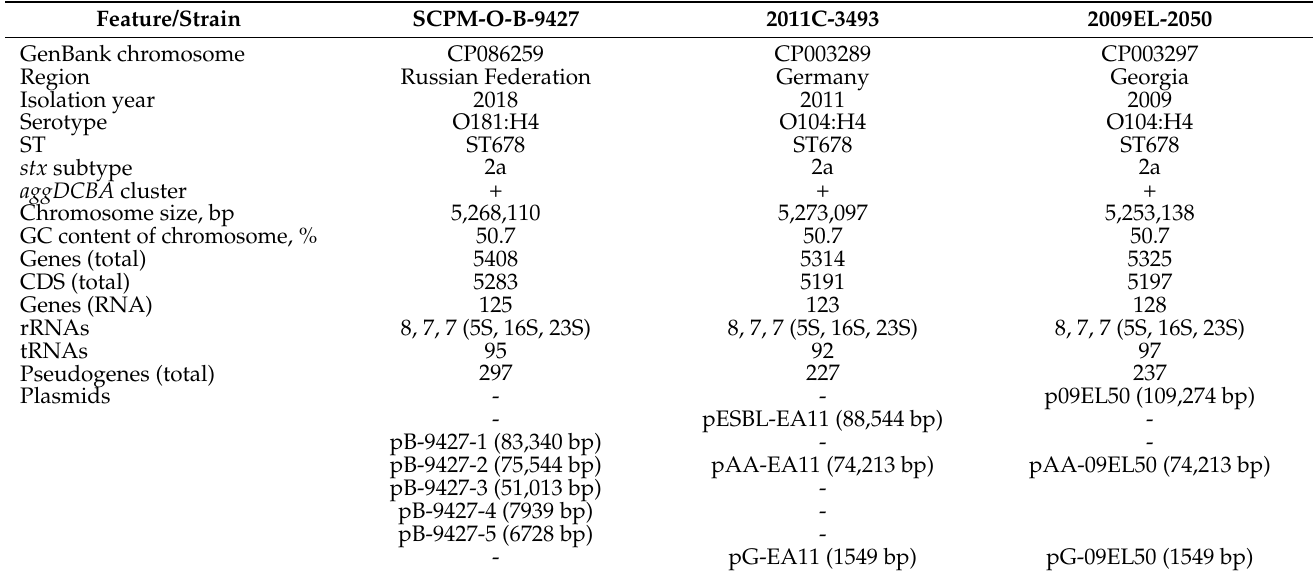
Table 2. Major genome characteristics of the EAHEC strains SCPM-O-B-9427, 2011C-3493, and